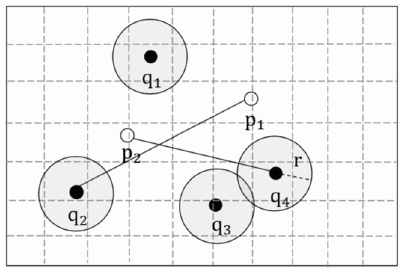
Figure 8. Circular secure areas.